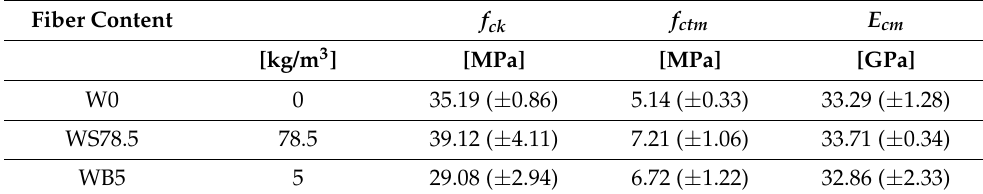
Table 1. Measured Average Values for Concrete with Various Contents of